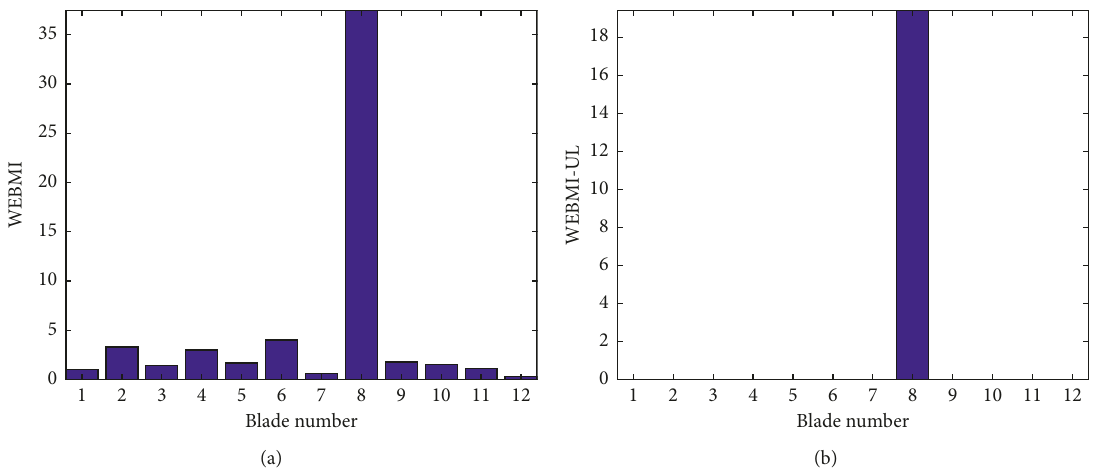
Figure 19: AECS results for the added mass located at blades 4 and 8. (a) WEBMI and (b) WEBMI-UL.